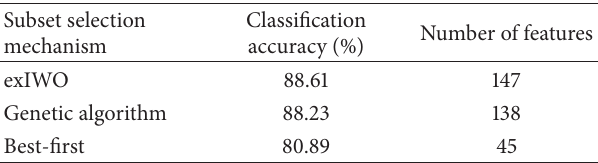
Table 6: Evaluation of the subset selection mechanisms for the Semeion Handwritten Digit Data